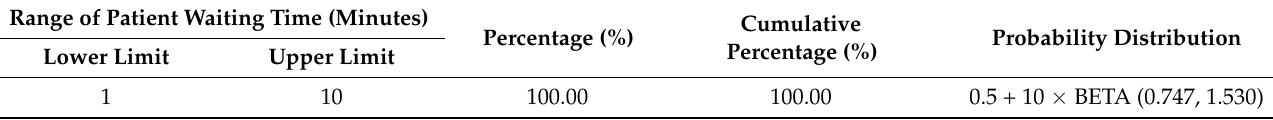
Table 4. Probability distribution for late